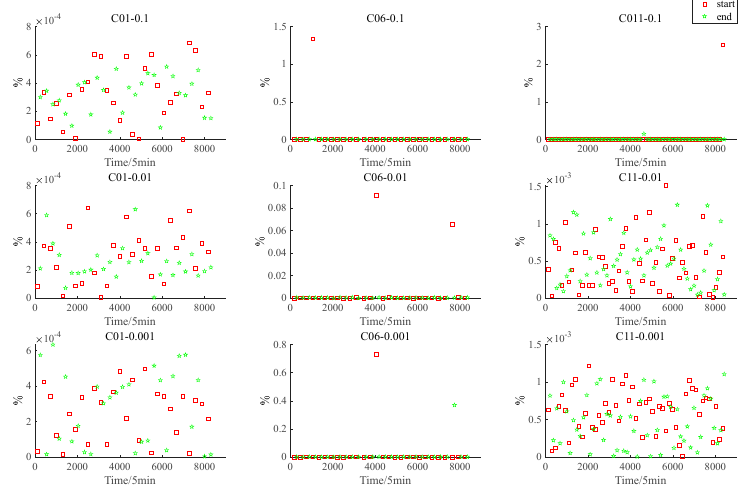
Figure 7. Graphs of C01, C06, and C11 satellite rise and set times.